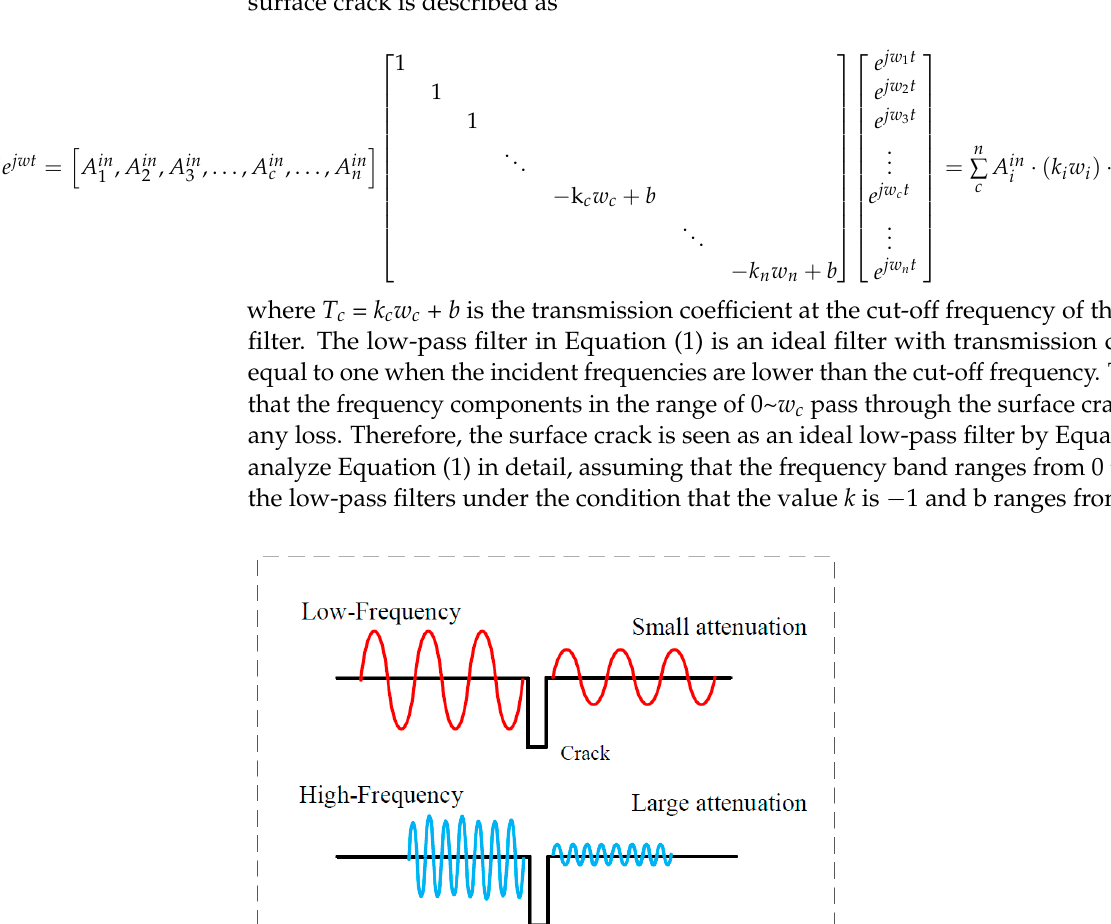
where T c = k c w c + b is the transmission coefficient at the cut-off frequency of the low-pass filter. The low-pass filter in Equation (1) is an ideal filter with transmission coefficients equal to one when the incident frequencies are lower than the cut-off frequency. This means that the frequency components in the range of 0~ w c pass through the surface crack without any loss. Therefore, the surface crack is seen as an ideal low-pass filter by Equation (1). To ana- lyze Equation (1) in detail, assuming that the frequency band ranges from 0 to ~5 MHz, the low-pass filters under the condition that the value k is − 1 and b ranges from 4 to 4.5. The reason that k was set as − 1 is to describe the relationship between the transmis- sion ability and the frequency of individual components as a negative correlation. This is consistent with the transmission ability of the components in the frequency band. The b in Equation (1), denoting the transmission ability of the Rayleigh wave, is related to the depth of the surface crack. It is seen in Figure 2 that under the different values of b the low-pass filters had similar properties in two parts, which are the passband from 0 to w c